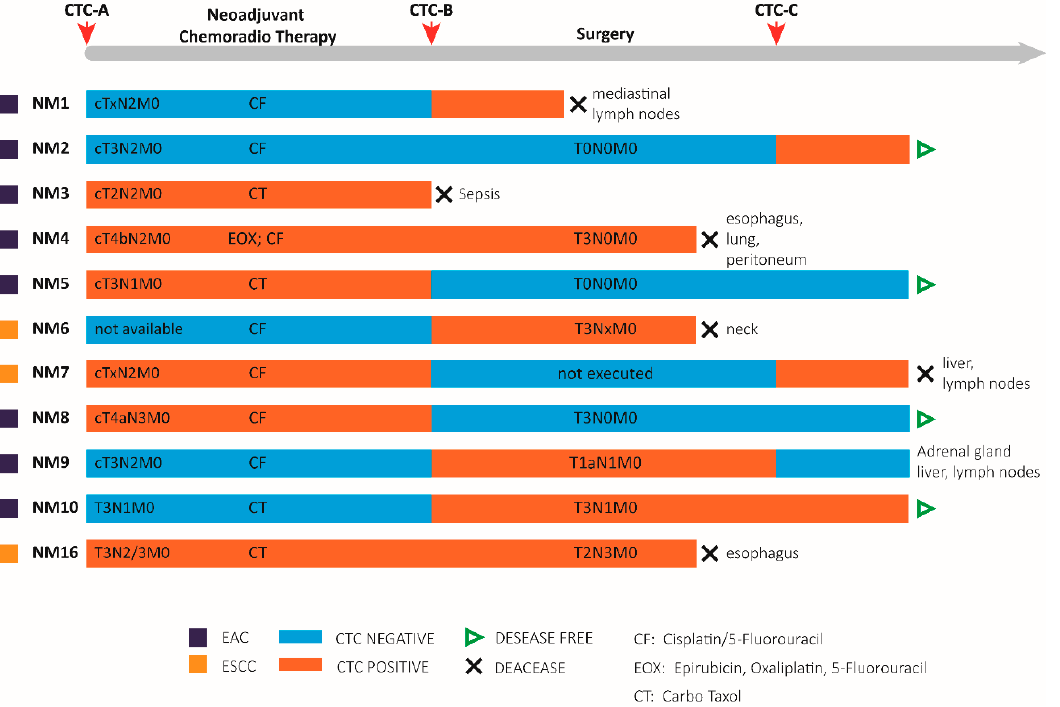
Figure 3. Summary of the clinical outcomes and CTC status of patients with non-metastatic esophageal cancer (EC). For each patient a timeline is defined along which we report: histological types (purple/ochre squares) EAC: esophageal adenocarcinoma cancer; ESCC: esophageal squamous cell carcinoma; TNM clinical classification based on the tumor (T), lymph node (N), and metastasis (M) system. ×: not assessed, neoadjuvant treatments, TNM pathological classification for patients that underwent surgery, clinical status (green arrows indicate disease/free status versus black arrows which indicate death), and in case of disease recurrence the site of relapse was specified. Blood draws time points are represented as red arrows at the top of the gray timeline bar. The presence or absence of CTCs (CTC status) is indicated by the color of the bars (light blue for CTC negativity and red for CTC positivity). CTC: circulating tumor cells.